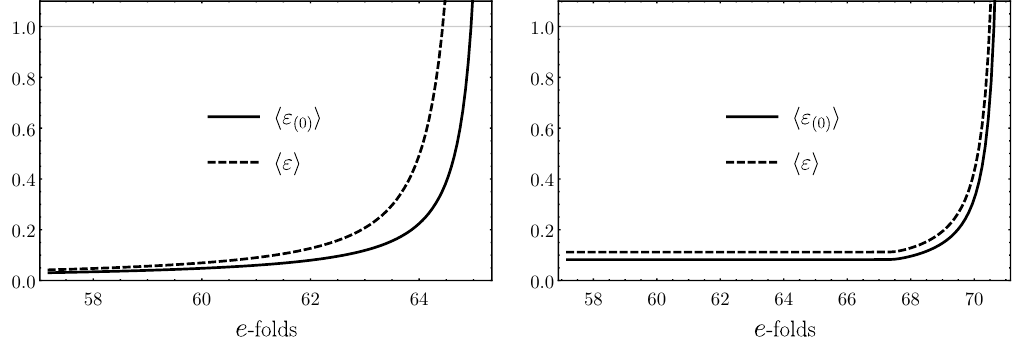
Figure 7 . Evolution of " for set 1 (left) and set 2 (right).